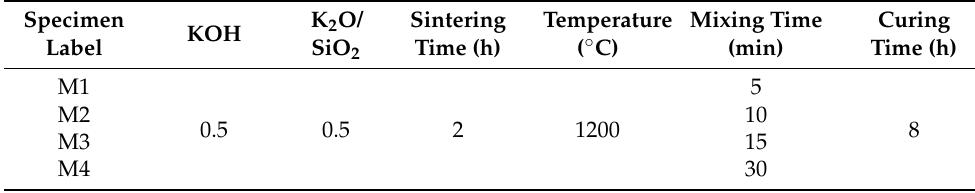
Table 5. Mixing proportion at different mixing times.